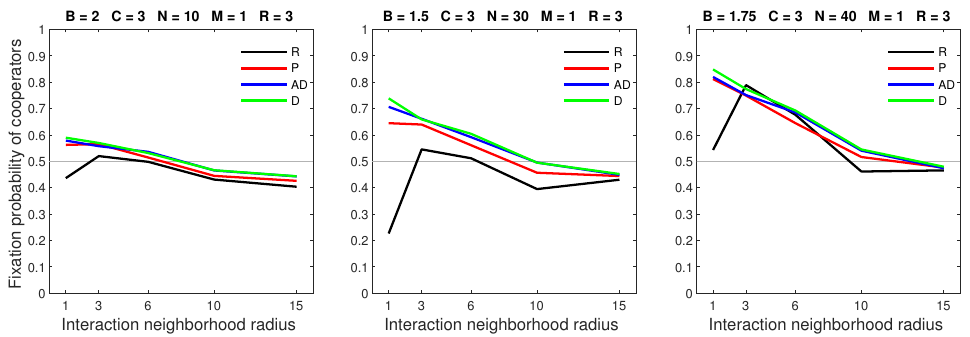
Figure 18. Deterministic and almost deterministic dispersal are more favorable to cooperators than probabilistic dispersal in settings with a low benefit–to–cost ratio and a neighborhood radius of